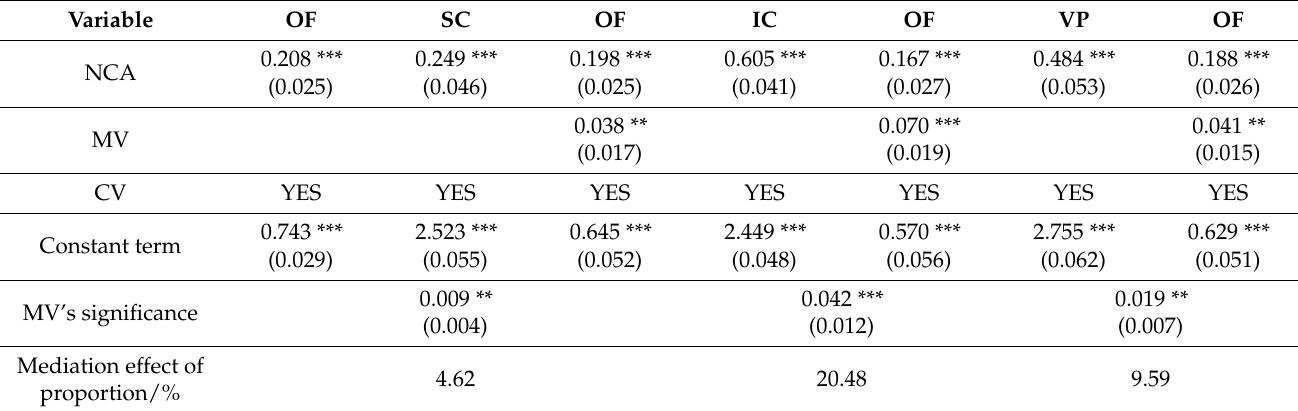
Table 4. Influence mechanism test of NCA on